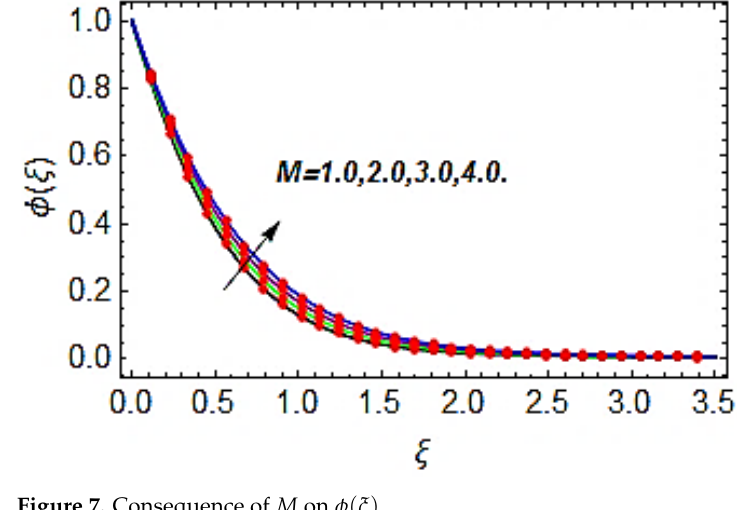
Figure 7. Consequence of M on φ ( ξ ) .